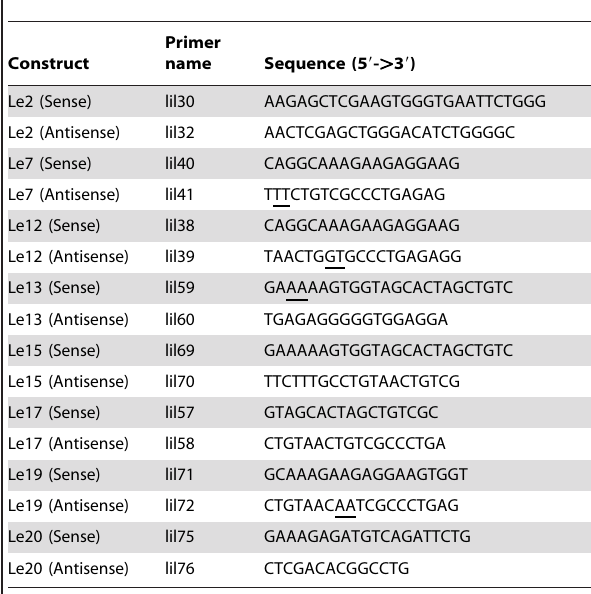
Table 1. Primers used for preparation of the vav 1 promoter